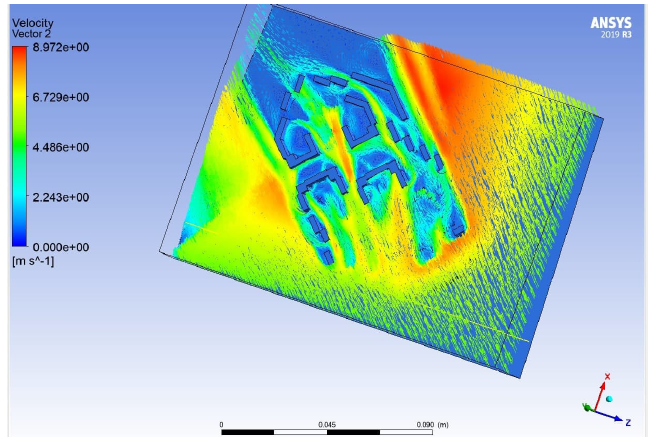
Figure 23. Velocity isofields obtained as a result of simulation, Level 2.